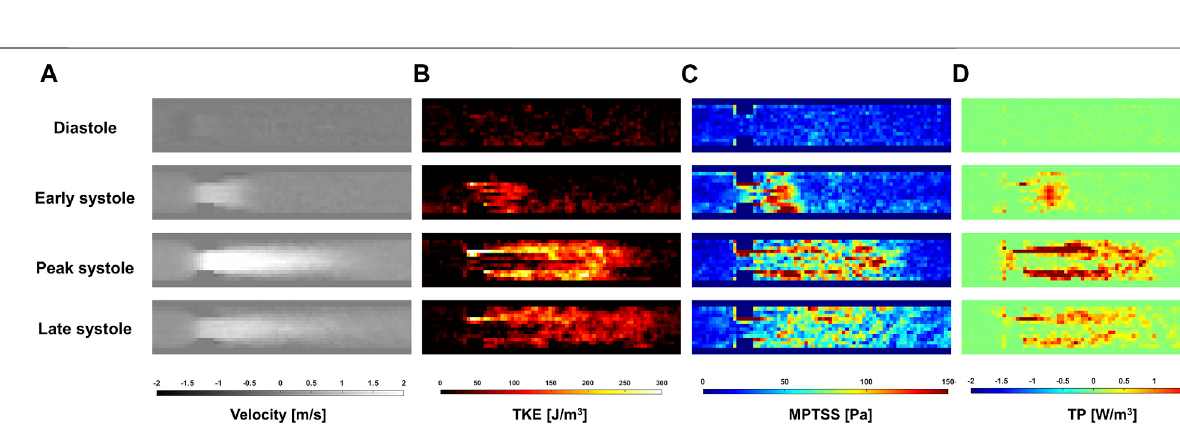
Frontiers in Bioengineering and Biotechnology |